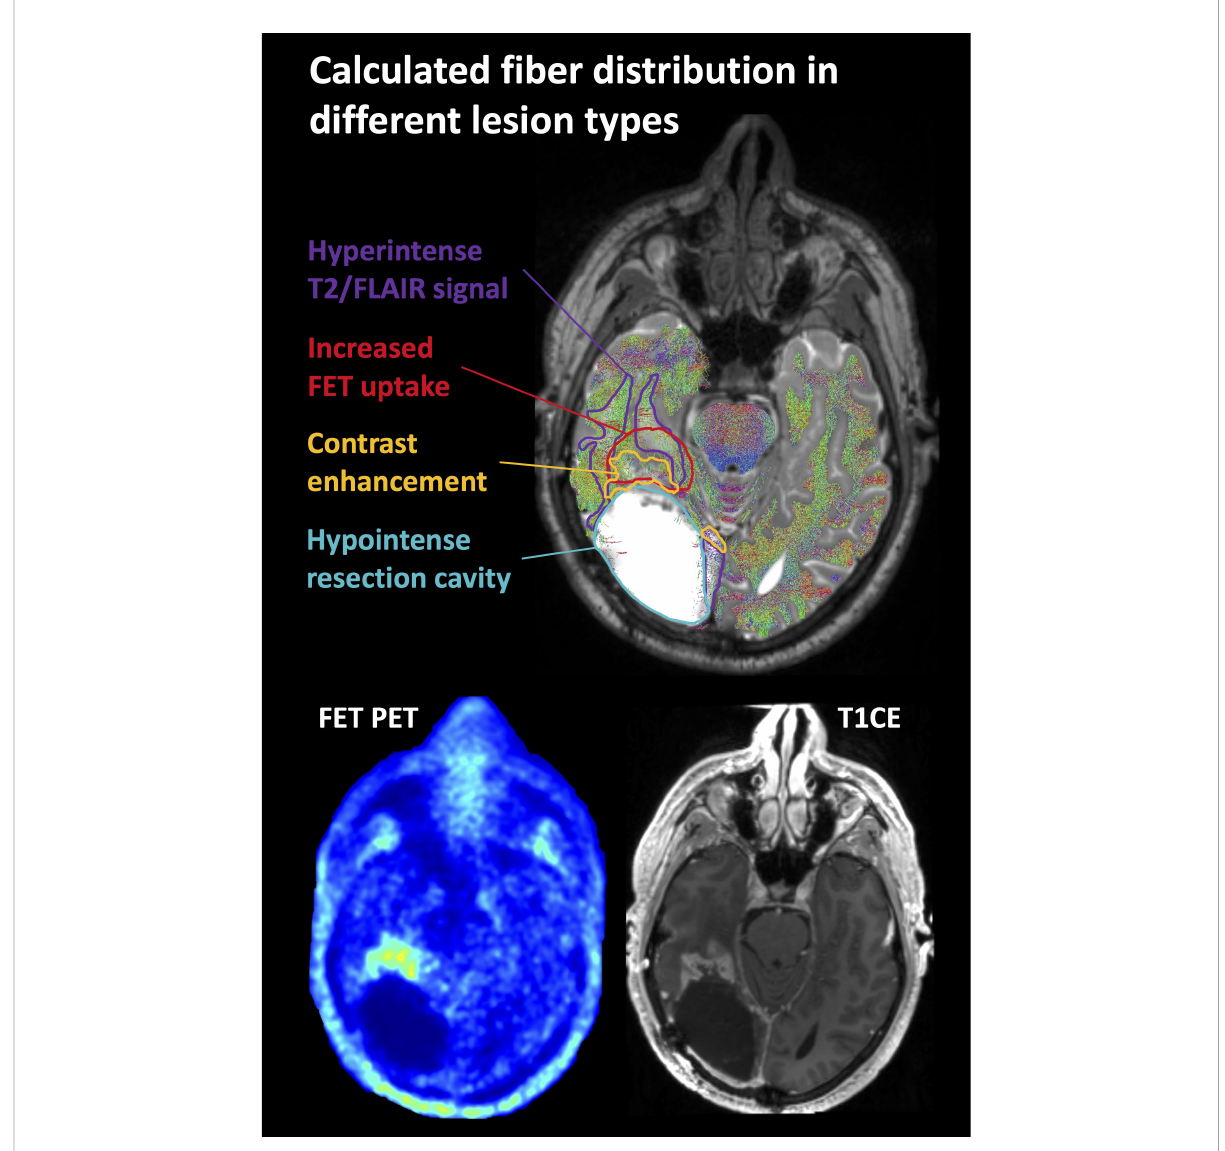
FIGURE 2 Representative case of lesion segmentation superimposed on a tractography image in a patient who had undergone surgery and radiochemotherapy and developed local recurrence near the resection cavity. FET, O-(2-[ 18 F] fl uoroethyl)-L-tyrosine; T2/FLAIR, T2-weighted fl uid-attenuated inversion recovery; T1CE, T1-weighted contrast-enhancing